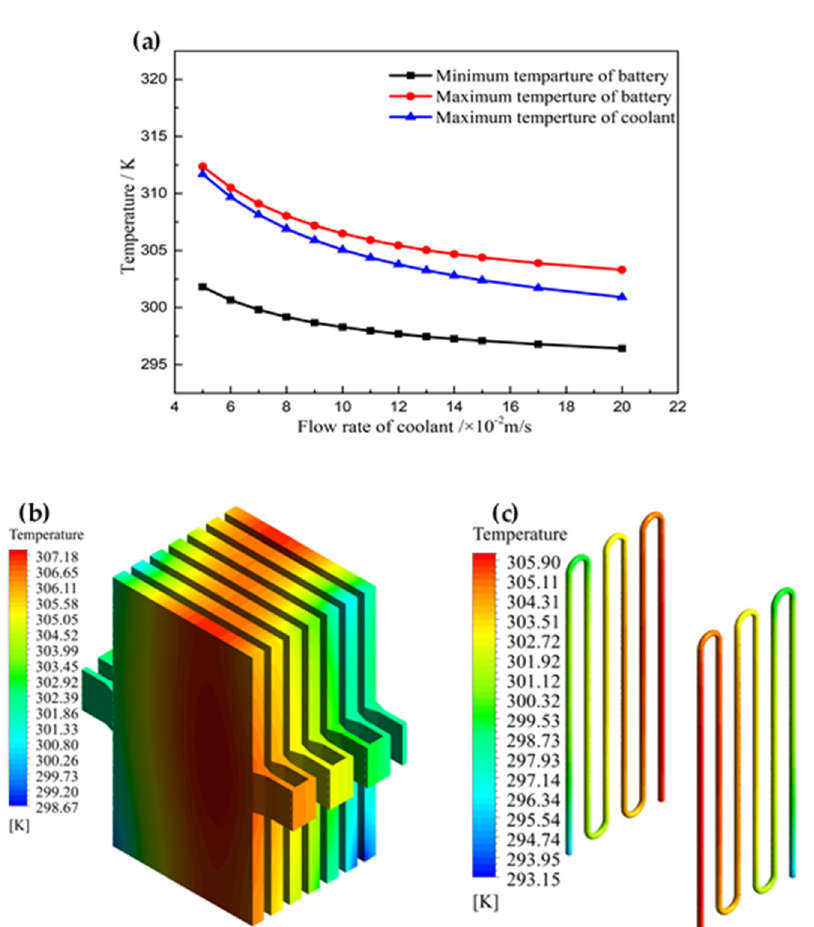
Figure 5. ( a ) Maximum and minimum temperature of battery pack and coolant maximum temper- ature; ( b ) and ( c ) show the temperature distribution of the battery pack and coolant for a flow rate of 0.09m/s, respectively. 0.09 m/s, respectively.